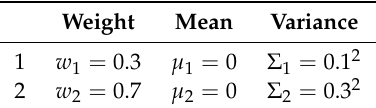
Table 1. The parameters of